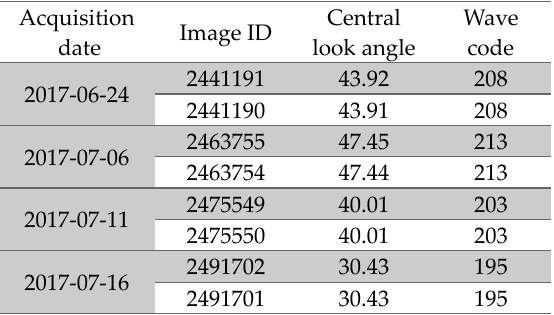
Table 1 . Parameters of the experimental GF-3 images